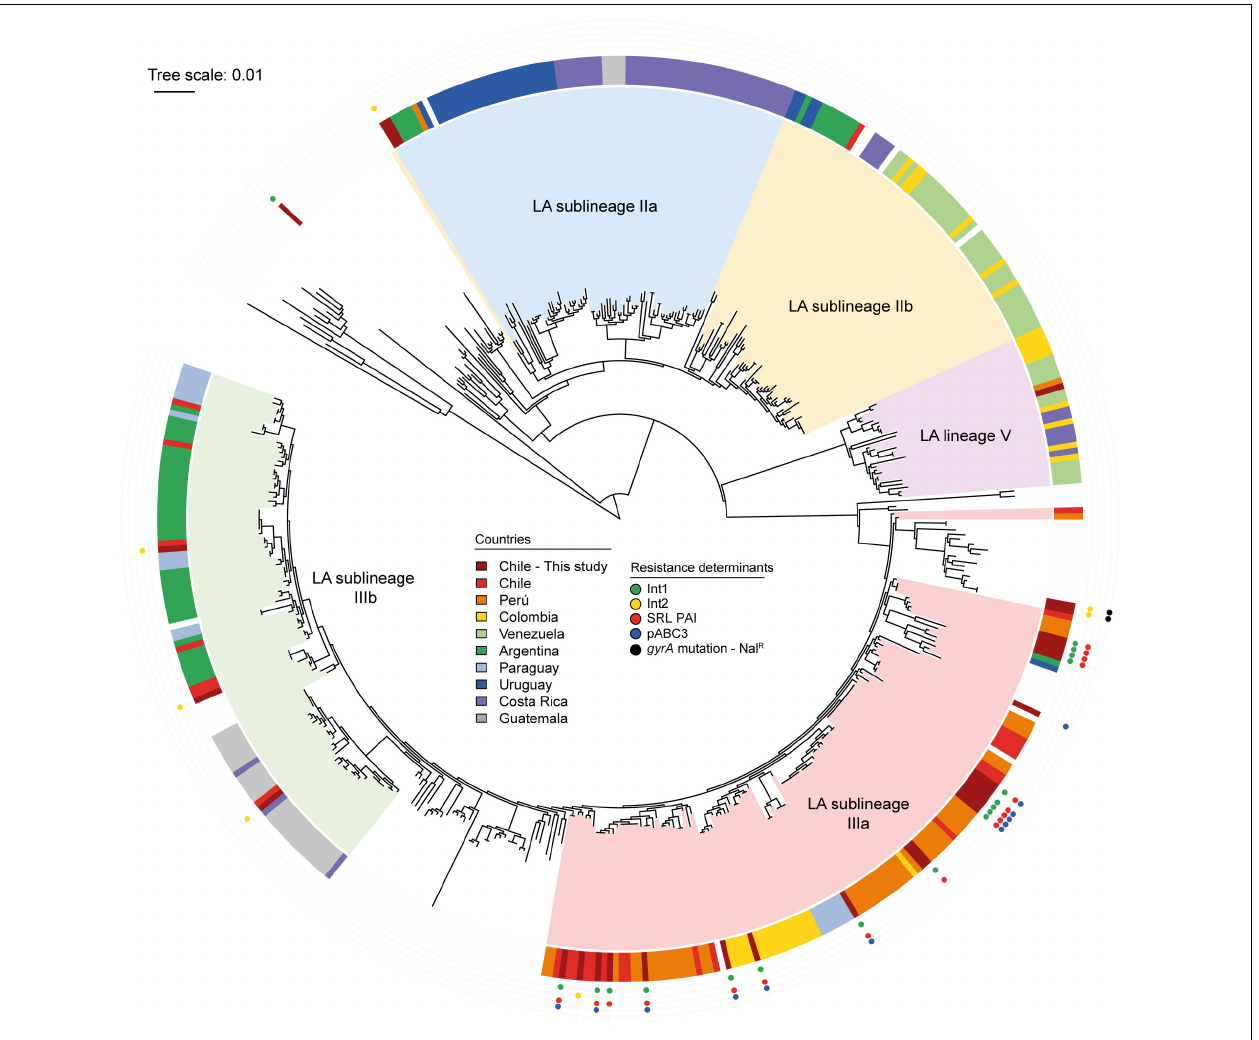
FIGURE 5 | Phylogenetic analysis of Shigella sonnei genomes sequenced in this study and publicly available S. sonnei genomes. Maximum likelihood phylogenetic tree (midpoint rooted) based on core genome SNPs showing phylogenetic relationships among 470 S. sonnei strains. The Latin-American (LA) lineages are based in the study by Baker et al. (2017). The country of origin of LA strains is shown in the colored ring, according to the legend. The global reference strains in the tree do not have country labels. The presence of antimicrobial resistance determinants of Chilean S. sonnei strains sequenced in this study is shown in the outer tracks, according to the legend. The tree was edited using iTOL (Letunic and Bork,